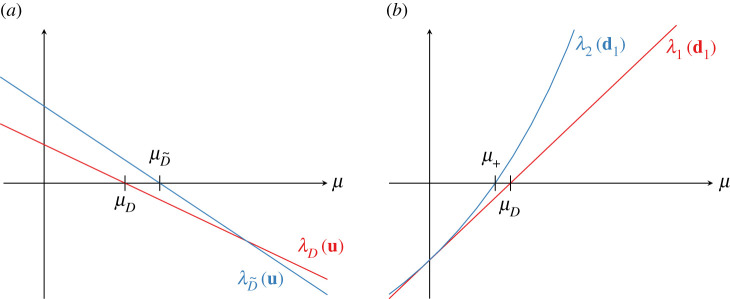
(a) The eigenvalues λD(u) and λ D~(u) of the Jacobian, evaluated at the uniform rest point u = (1/2, 1/2), as a function of mutation rate μ. (b) The eigenvalues λ1(d1) and λ2(d1) of the Jacobian, evaluated at the diagonal rest point d1 (see text), as a function of mutation rate μ.